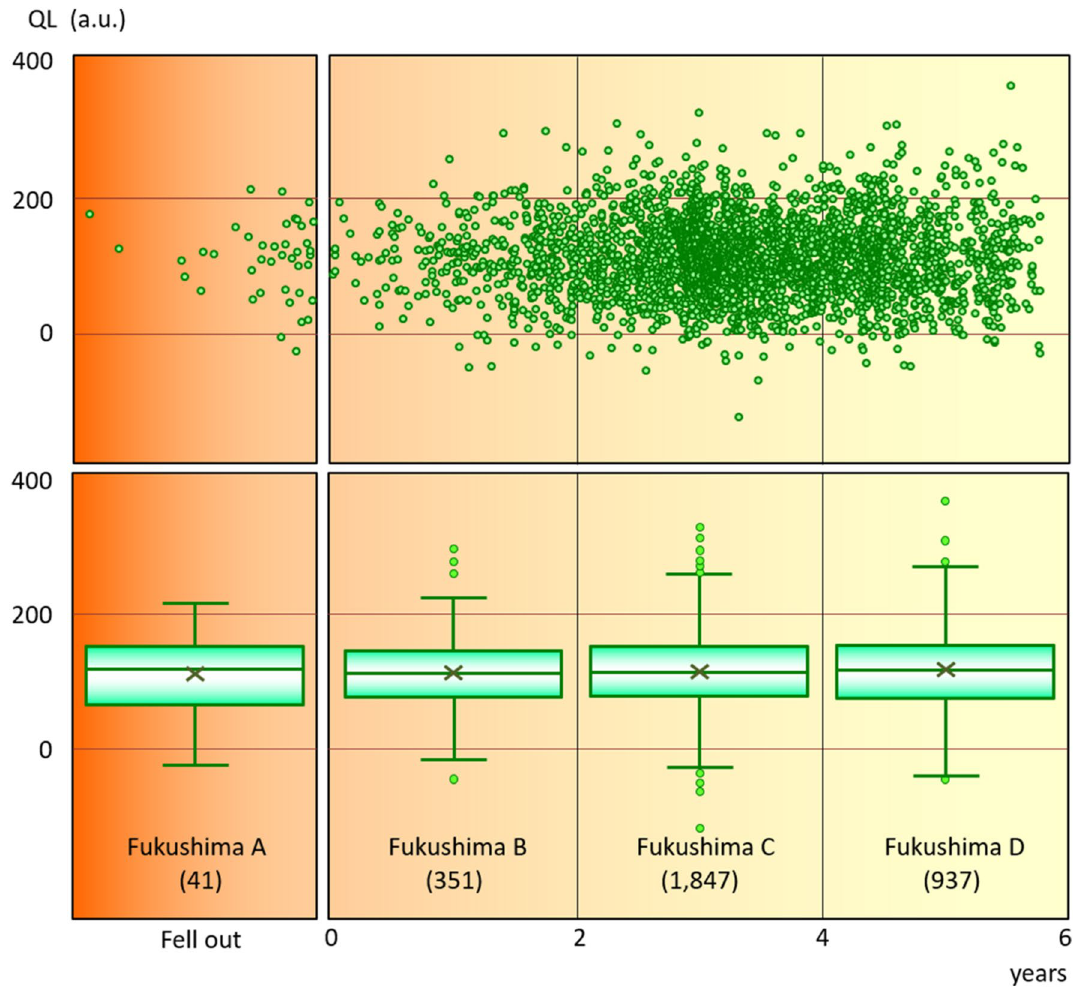
Figure 5. Quantum levels (QL) of teeth in different duration of time teeth remained in the oral cavity after the FNPP accident. Parentheses show numbers of teeth. a.u.: arbitrary